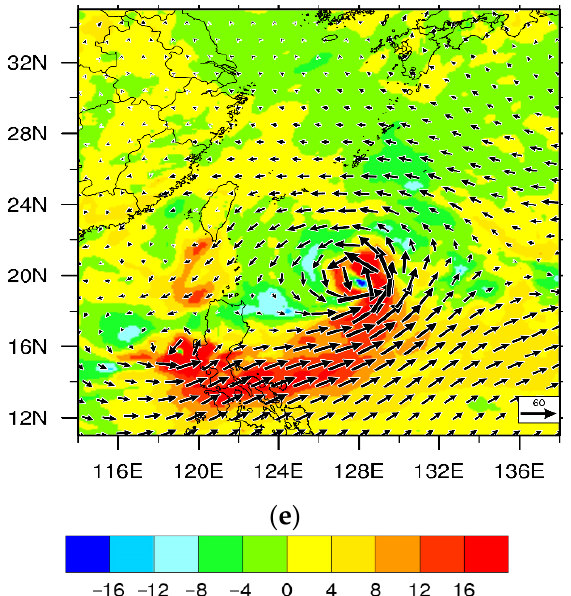
Figure 18. Water vapor flux difference (shaded, (kg × m/s − 2 )/m − 2 ) of 24-h forecasts initialized from 0000 UTC 06 August 2019 at 850 hPa. ( a ) CDA-3 minus ERA-5, ( b ) CDA-2 minus ERA-5, ( c ) CDA-1 minus ERA-5, ( d ) SDA minus ERA-5, and ( e ) NDA minus ERA-5.